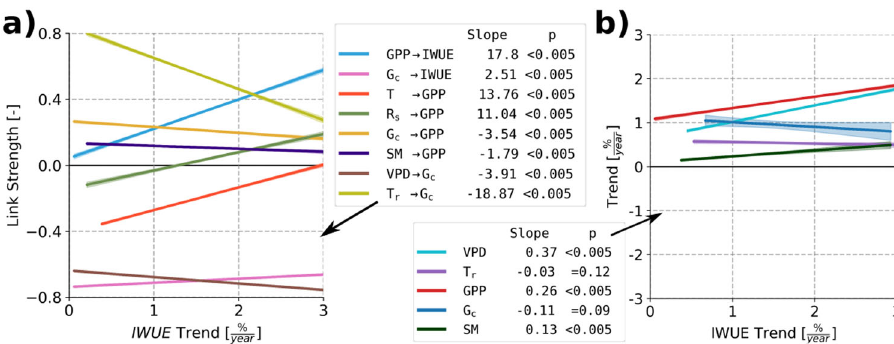
Fig. 5 Strongly increasing IWUE in European grasslands are the result of regulated T r and increasing GPP. We show in ( a ) the link strengths (y-axis, color lines) as linear regression function of the IWUE trend (x-axis). The 95% con fi dence interval was plotted but is minimal for all. The slope and p values of the regression are given in the fi gure legend. In ( b ) the linear regression of trend slopes of other relevant variables (y-axis, color lines) are plotted against the respective IWUE trend (x-axis). Again, the slope and p values are given in the fi gure legend. The stronger the positive IWUE trend, we note stronger GPP in fl uence in ( a , blue line) and the stronger the GPP trend slope, too ( b , red line). At the same time, although vapour pressure de fi cit (VPD) is rising ( b , light blue line), transpiration (T r , b , purple line) was regulated by decreasing canopy conductance (G c , b , dark blue line), resulting in the strong